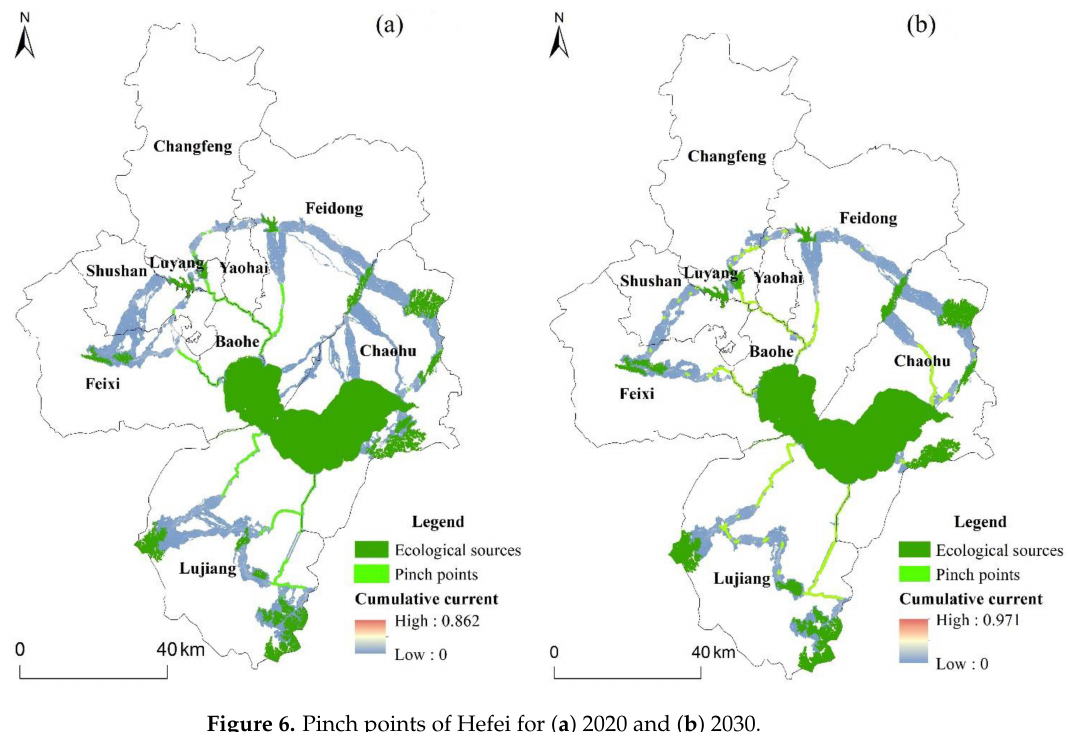
Figure 6. Pinch points of Hefei for ( a ) 2020 and ( b ) 2030.